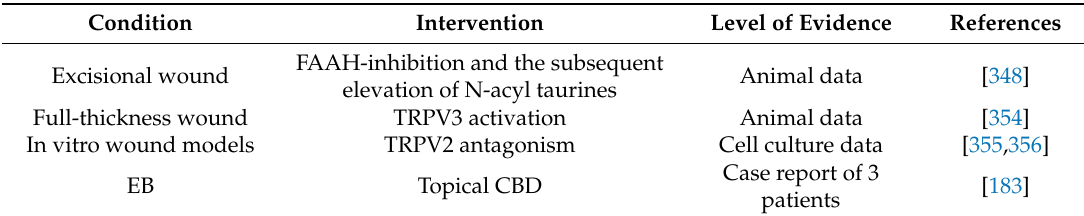
Table 6. Overview of the putative wound healing-relevant therapeutic potential of cutaneous cannabinoid